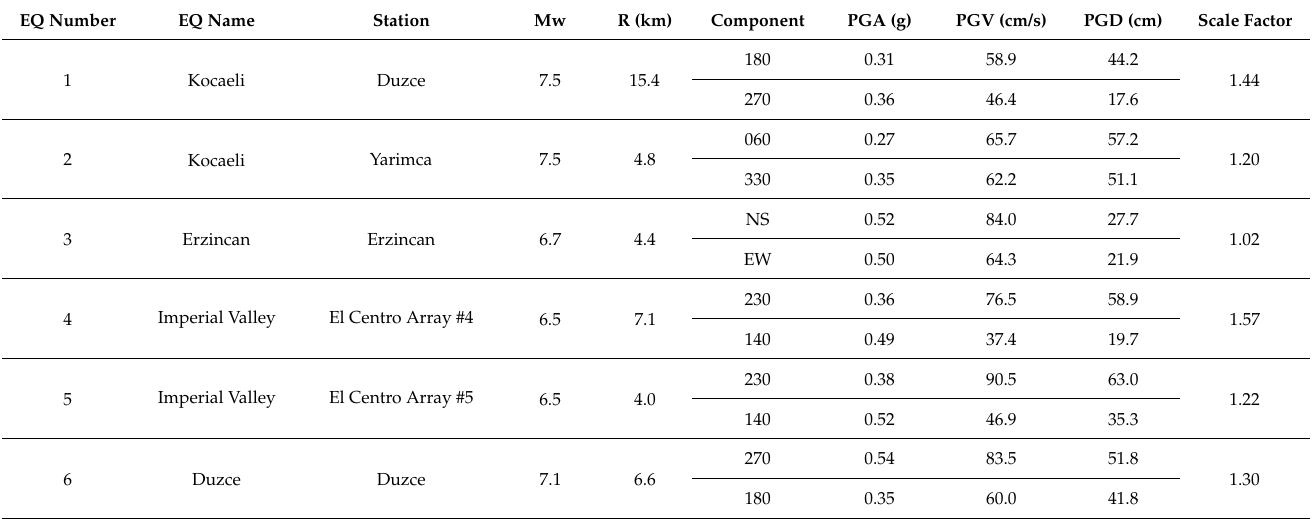
Table 3. The selected ground motion